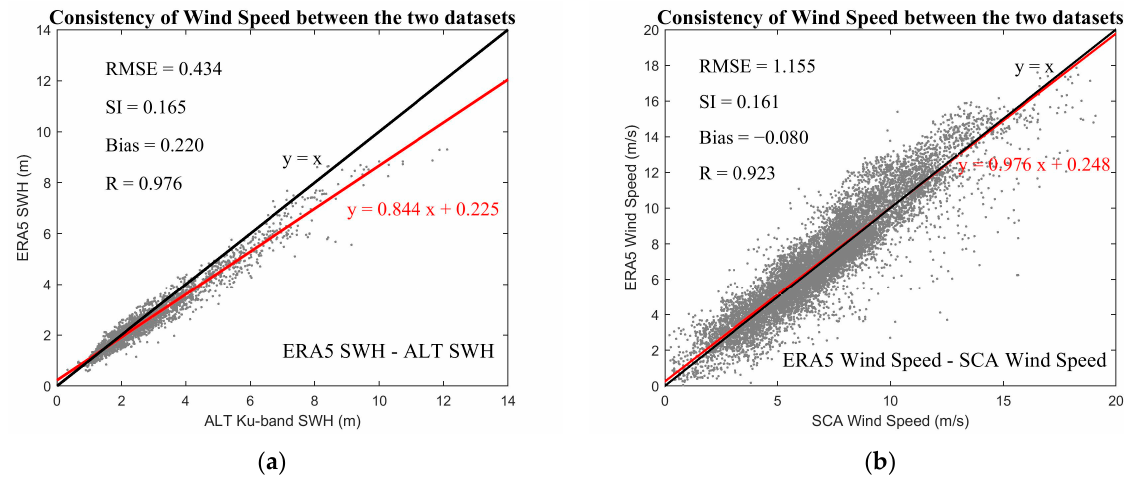
Figure 2. Scatter plots of SWH ( a ) and wind speed ( b ) from HY-2C and ERA5 to check the consistency. The red lines indicate the linear fit and the black lines mean the full correlation.